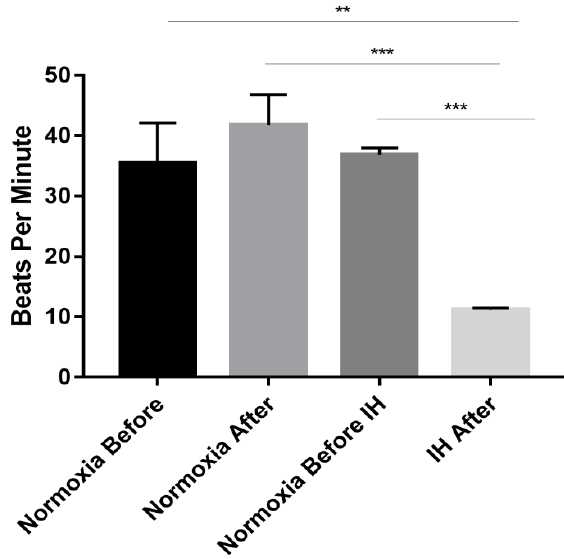
Figure 2. Decrease in hESC-CMs beating rate following IH. Beats per minute were determined on cells under normoxic conditions (21% O 2 , 37 °C) or intermittent hypoxia (IH) (1% O 2 , 37 °C) for 12 h (60 Cycles). Results are averages of 3 separate experiments. Each experiment was performed on 15 wells, in each well 10 contracting CMs cell aggregates were counted under the microscope. A total of 450 CMs in each group was scored. ANOVA analysis ** p = 0.001, *** p <